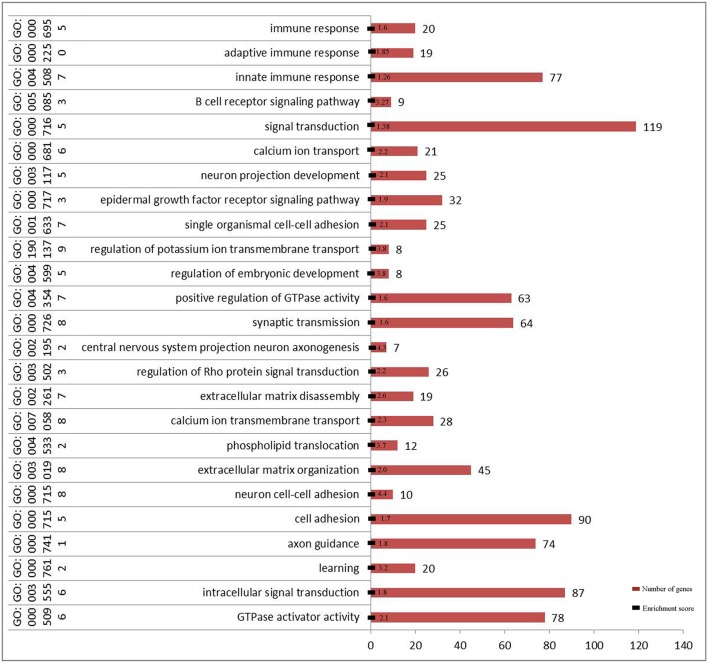
Significant function of GO enrichment analysis (biological process) in 2b-RADseq stage (FDR < 0.001).